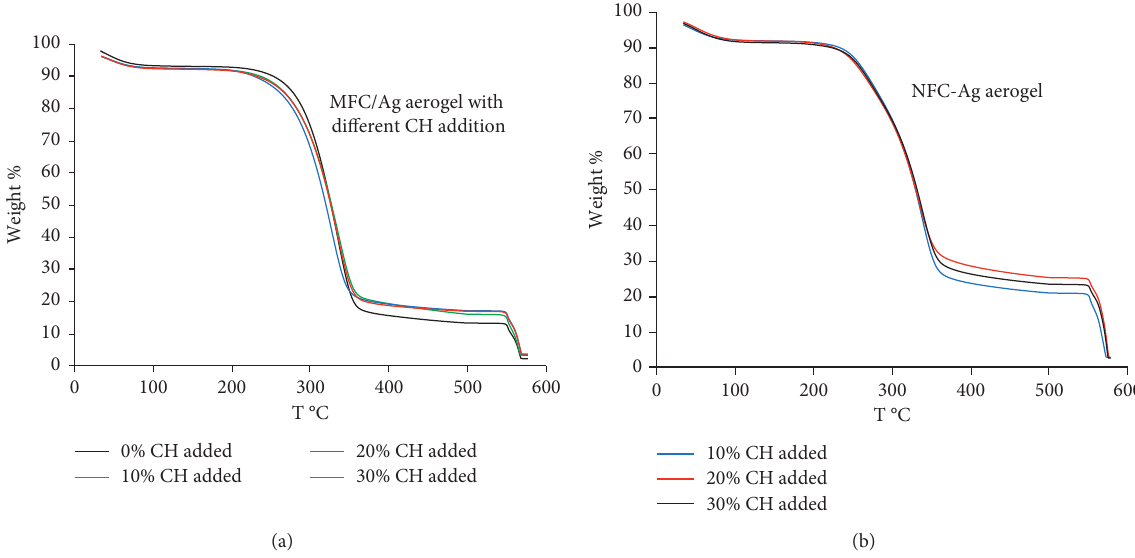
Figure 5: TGA behavior of MFC-Ag aerogels with different chitosan addition and NFC-Ag aerogels with different chitosan addition. Note: TGA under N2 atmosphere till 500 ° C and then switched to oxygen to 575 °